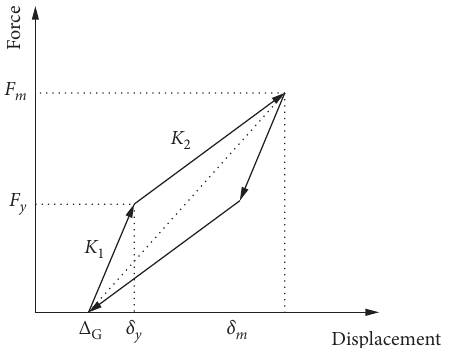
Figure 4: Hertz-damp model for pounding simulation.